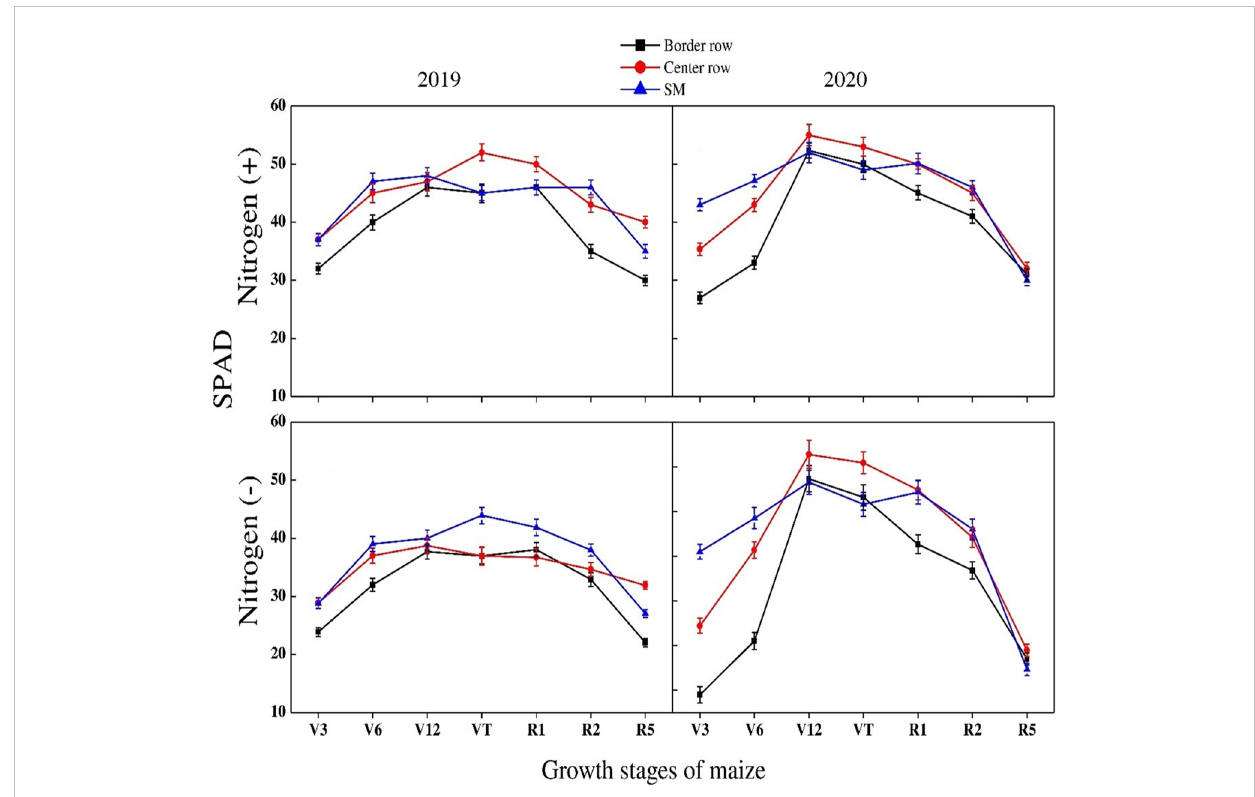
FIGURE 9 SPAD values of the border-, center- and sole maize (SM) crop at various growth stages under with- and without N application. Different letters on the top of each bar indicate signi fi cant differences among the various crop growth stages, as calculated by Tukey ’ s HSD test at P ≤